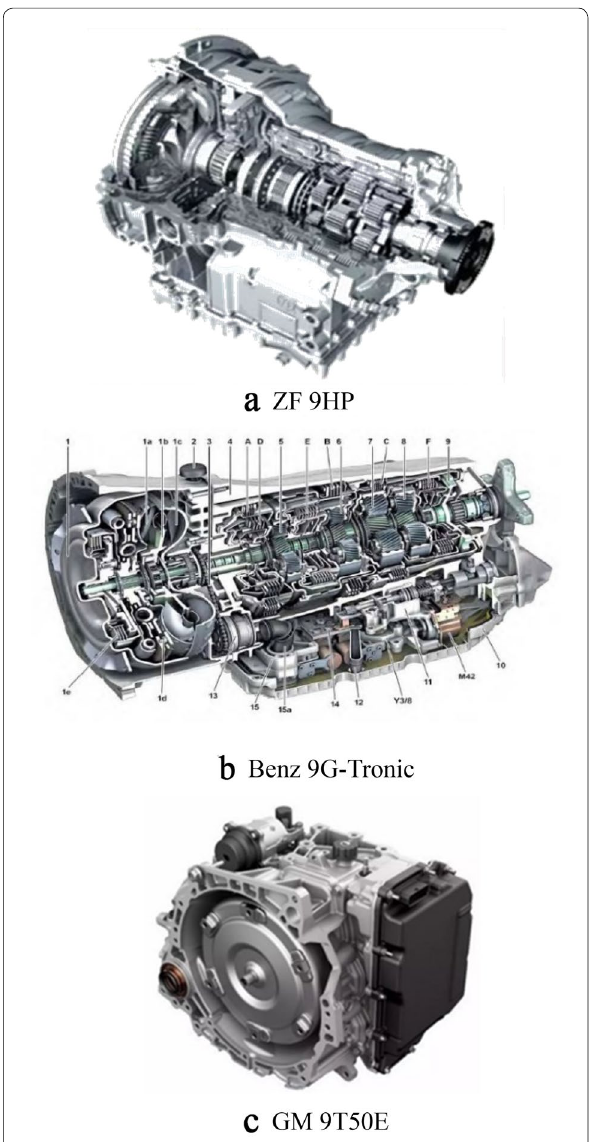
Figure 1 Configuration of different existing 9-speed ATs